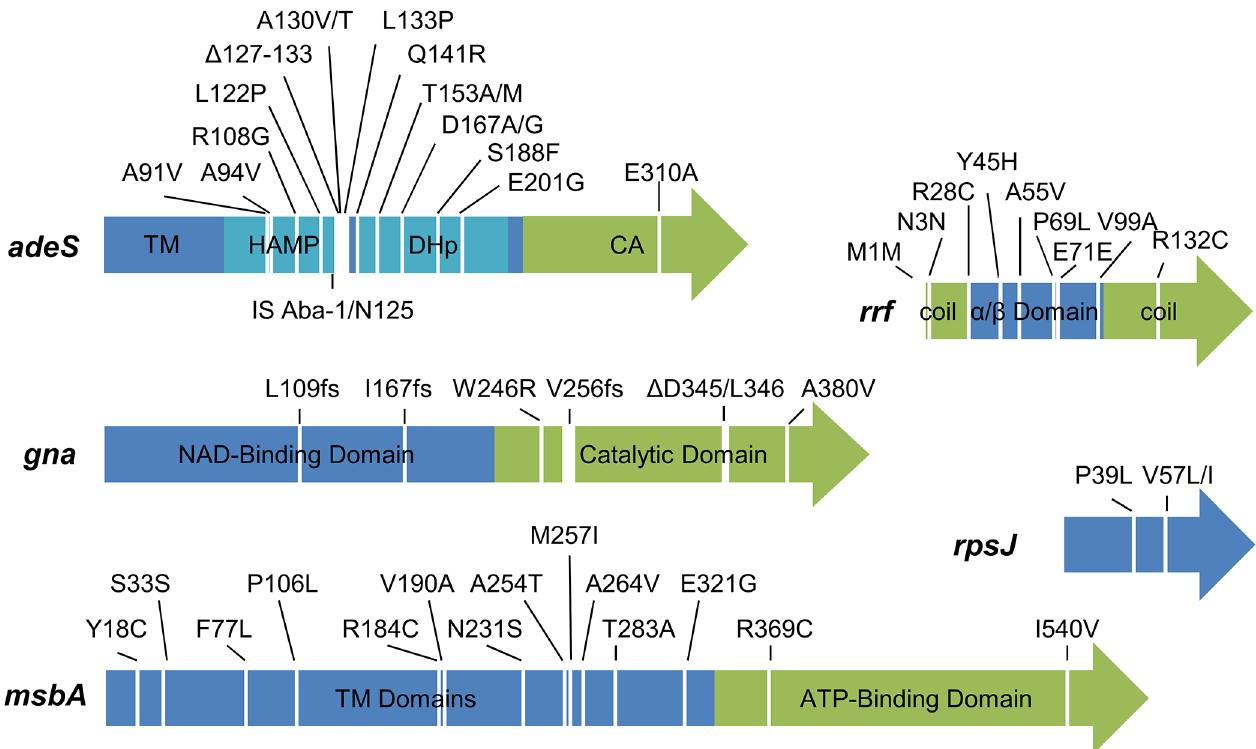
Fig 7. Mutations in genes that may reduce TGC susceptibility. Arrows represent the coding regions. The labels indicate the amino acid changes present in each protein. If a position was mutated to more than one residue, the two amino acids are listed, for example “ A130V/T ” indicates A130 was mutated to both a valine and threonine. Frameshift mutations are indicated by “ fs ” . For multi-domain proteins, the predicted domains are represented by different colors. HAMP, histidine kinase, adenyl cyclase, methyl-accepting protein, and phosphatase linker; DHp, dimerization and histidine-containing phosphotransfer domain; CA, catalytic and ATP-binding domain; TM, transmembrane